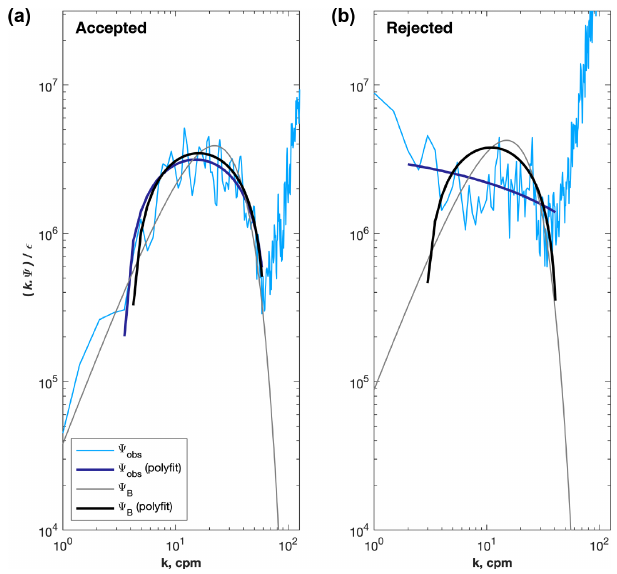
Figure 2. Example of temperature spectra, (cid:57) , that were ac- cepted (a) and rejected (b) by the quality control algorithm. Ob- served and theoretical spectra are shown by the thin, light-coloured lines; the second-order polynomial fits are shown by thick, dark- coloured